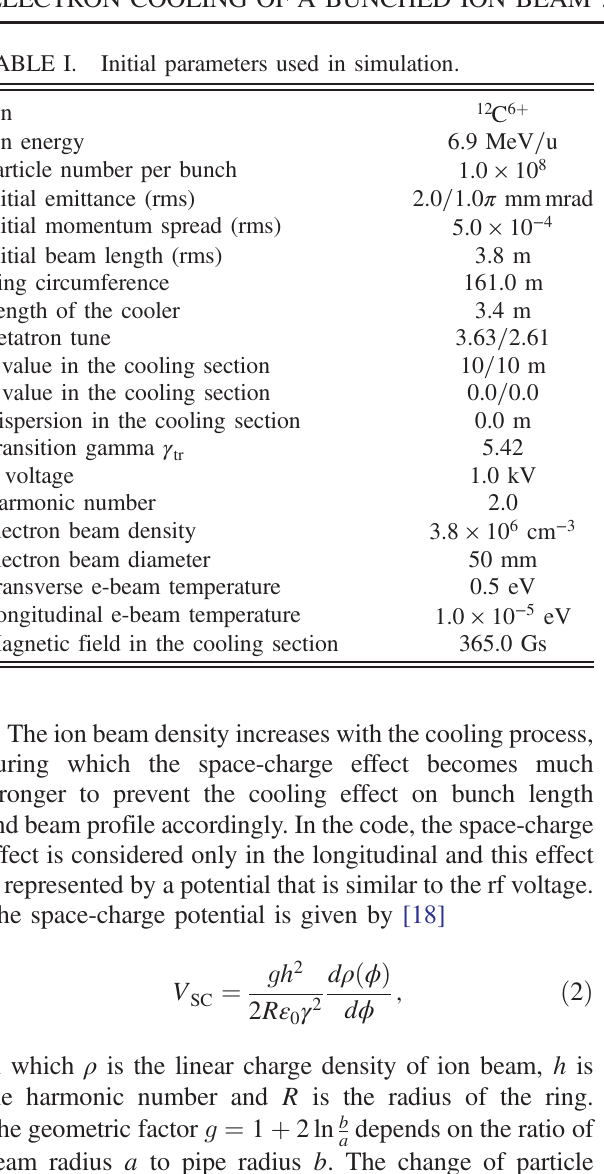
¼ 1 . 0 kV) for 6 . 9 MeV =u 12 C 6 þ rf